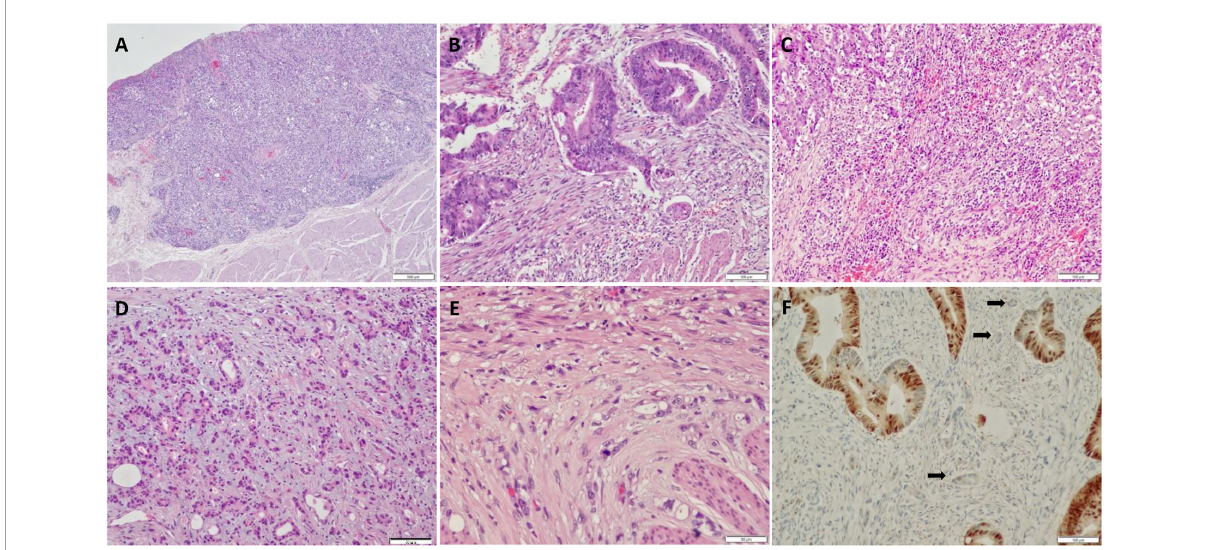
FIGURE1 Histological and immunohistochemical features of pT1 colorectal cancer (CRC). (A) High histology grade; (B) lymph-vascular invasion observed in a biopsy specimen; (C) inflammatory stroma surrounding tumor budding (TB); (D) myxoid stroma surrounding TB; (E) mitosis present in TB; (F) CDX2 expression in tumor cells, while loss of expression in TB.